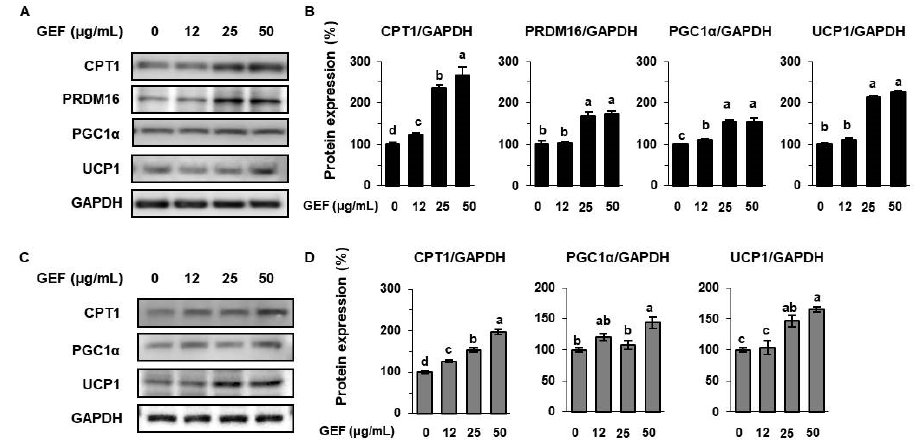
Figure4. E ff ectsofGEFontheexpressionofthermogenicproteinsin3T3-L1sandSATs. ( A , B )Expression Figure 4. Effects of GEF on the expression of thermogenic proteins in 3T3-L1s and SATs. ( A–B ) of thermogenic proteins (CPT1, PR domain-containing 16 (PRDM16), peroxisome proliferator-activated Expression of thermogenic proteins (CPT1, PR domain-containing 16 (PRDM16), peroxisome receptor gamma co-activator 1 α (PGC1 α ), and uncoupling protein 1 (UCP1)) in 3T3-L1s. ( C , D ) proliferator-activated receptor gamma co-activator 1 α (PGC1α), and uncoupling protein 1 (UCP1)) Expression of thermogenic proteins in SATs. Treatments with di ff erent letters were significantly in 3T3-L1s. ( C–D ) Expression of thermogenic proteins in SATs. Treatments with different letters were di ff erent, p < 0.05 (a > b > c > significantly different, p < 0.05 (a > b > c > d).